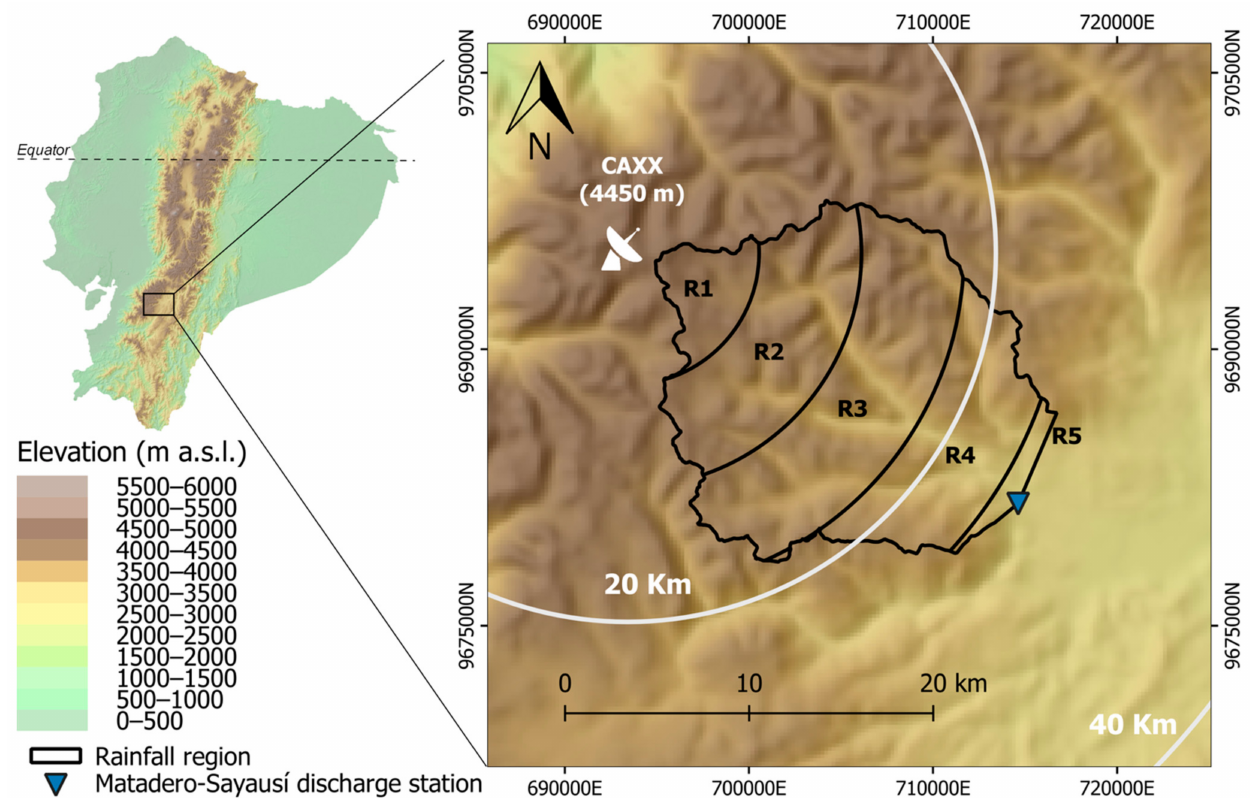
Figure 1. Map of the study site and division of the five rainfall